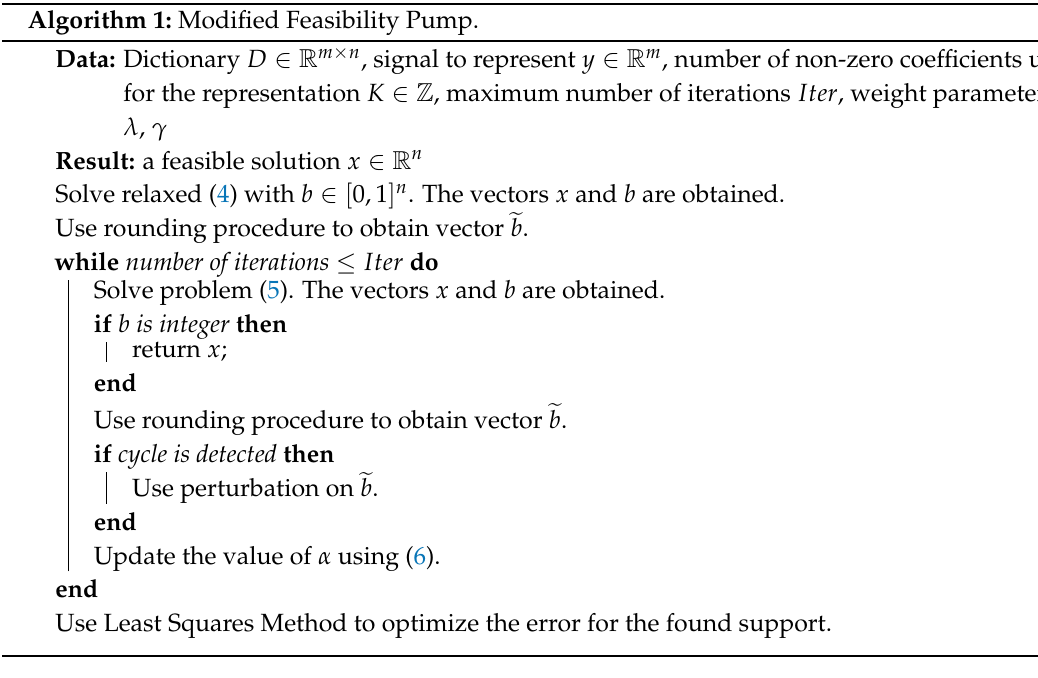
Algorithm 1: Modified Feasibility